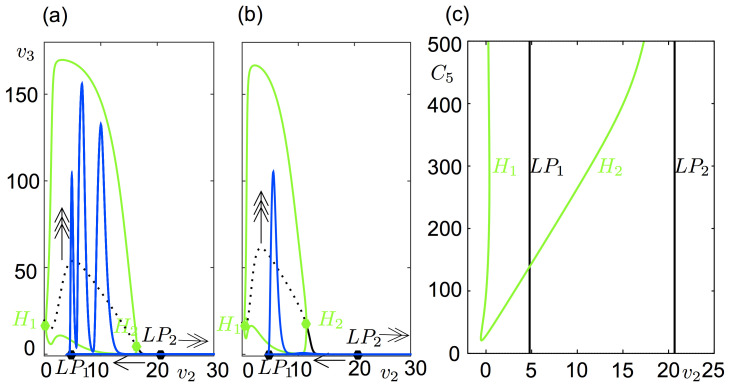
Spike number as a function of C5.(a) Solution of (4) with 3 spikes for C5 = 500 projected on the bifurcation diagram of the fast system (5) as a function of v2. Arrows indicate the direction of the flow. (b) Solution of (4) with 1 spike for C5 = 300 projected on the bifurcation diagram of the fast system (5) as a function of v2. Arrows indicate the direction of the flow. (c) Co-dimension 2 diagrams of the Hopf (H) points (green) and the limit points (LP, black) in the (v2, C5) parameter space marked on the left and middle panels. As C5 decreases, H2 moves leftwards and eventually the spike number decreases. For C5 = 139, H2 and LP1 are aligned at v2 = 4.778. A further decrease in C5 places H2 on the left of LP1 and leaves no chances for a bursting solution.